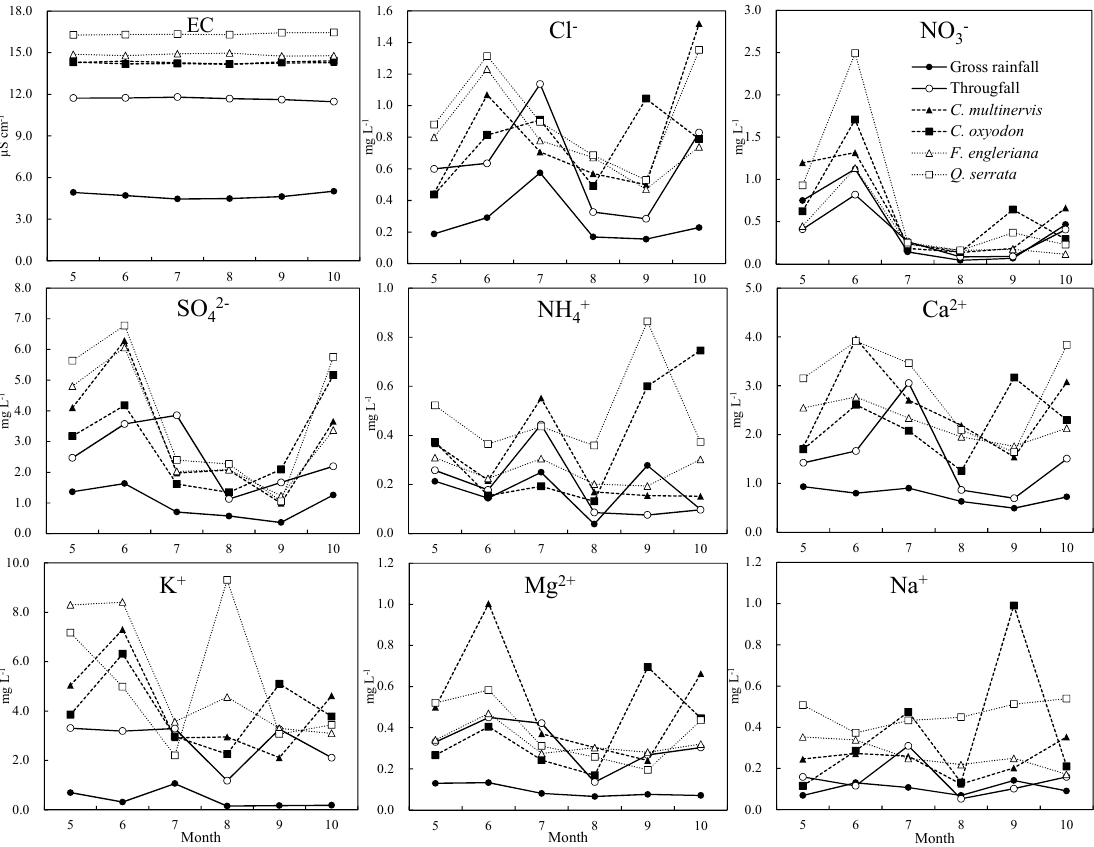
Figure 4. Monthly variation in chemical characteristic in waters of different type pathways and species of trees.